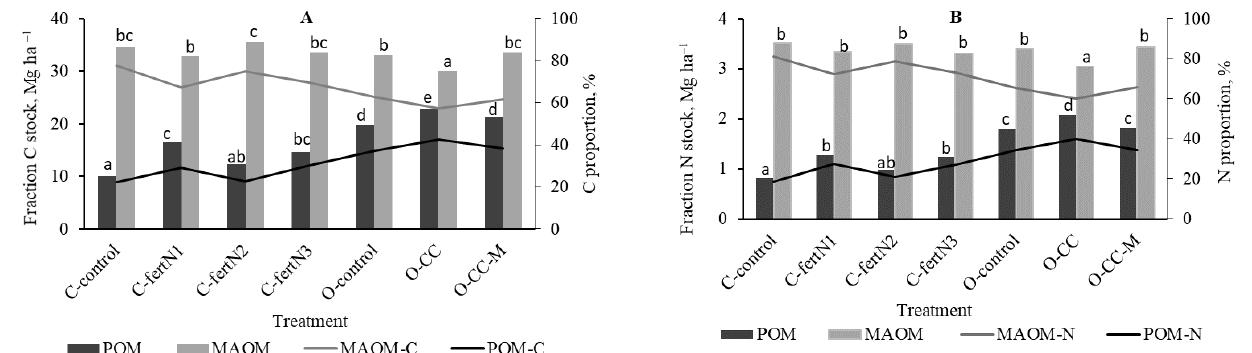
Figure 1. Soil organic carbon (SOC) ( A ) and nitrogen (N) ( B ) stocks and proportions depending on treatments. Different lowercase letters above the columns indicate a statistically significant ( p < 0.05) difference between treatments within the POM or MAOM fraction.